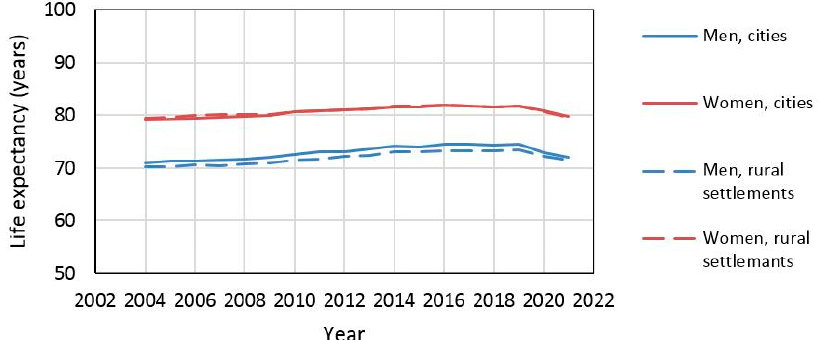
Figure 14. Life expectancy for urban and rural populations in Poland, age class less than 1 year, data obtained from [66].